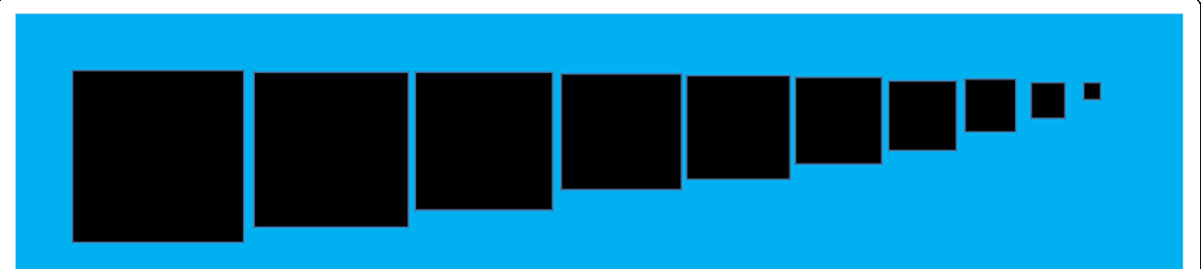
Fig. 9 Group diagram of the square to be identified decremented from 100% by